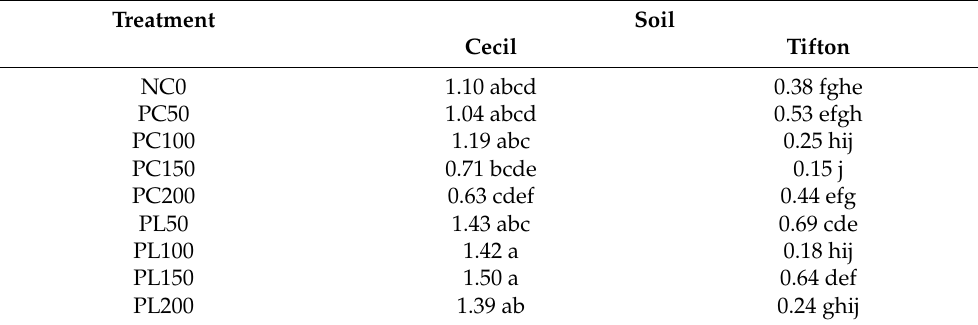
Table 5. Total soil respiration (total g CO2-C kg soil) emitted over a 28-day incubation. Treatment